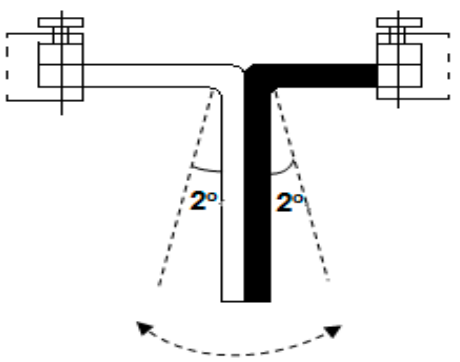
Figure 6. Deviation in peel angle during T-peel.